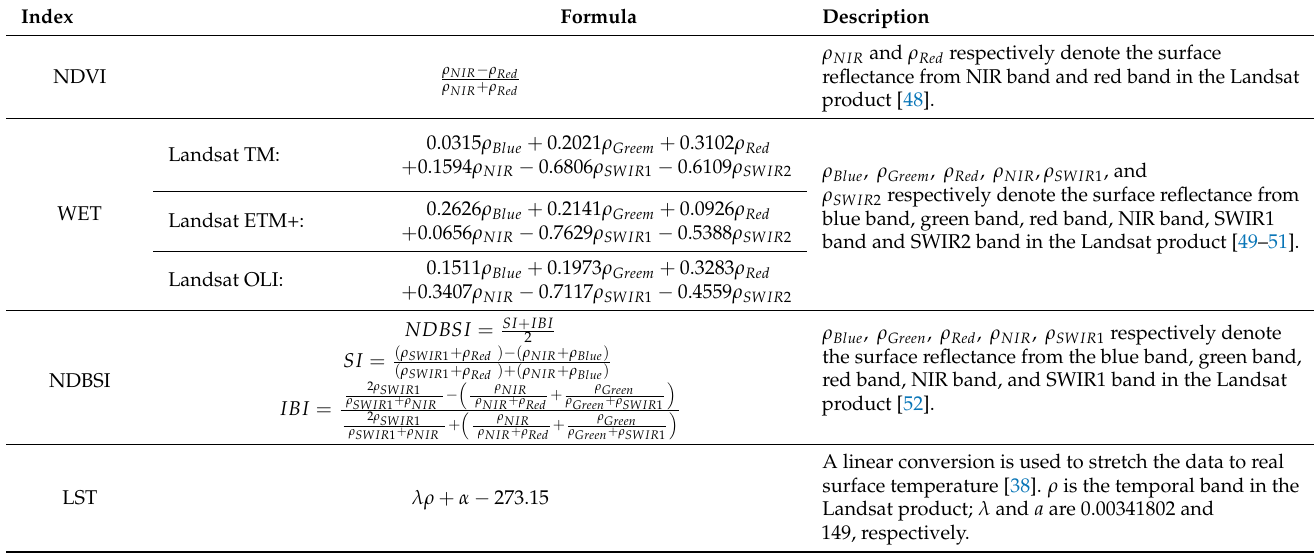
Table 2. Formula and description for each remote-sensing